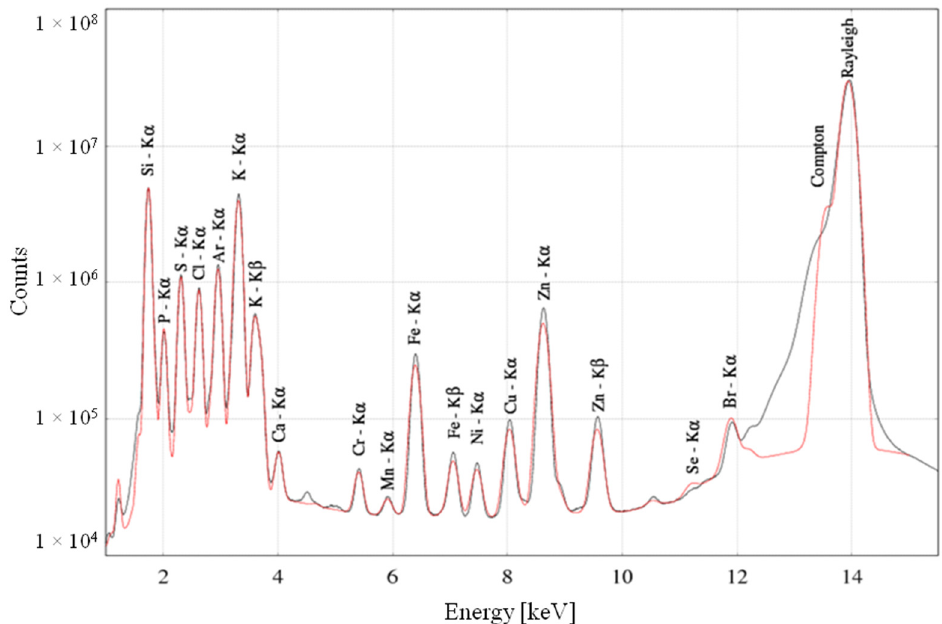
Figure 7. The spectrum of characteristic X ‐ ray radiation of a selected fibre from the reference group. The measured spectrum is marked with the black line, and the red line shows the fit by the PyMca program.